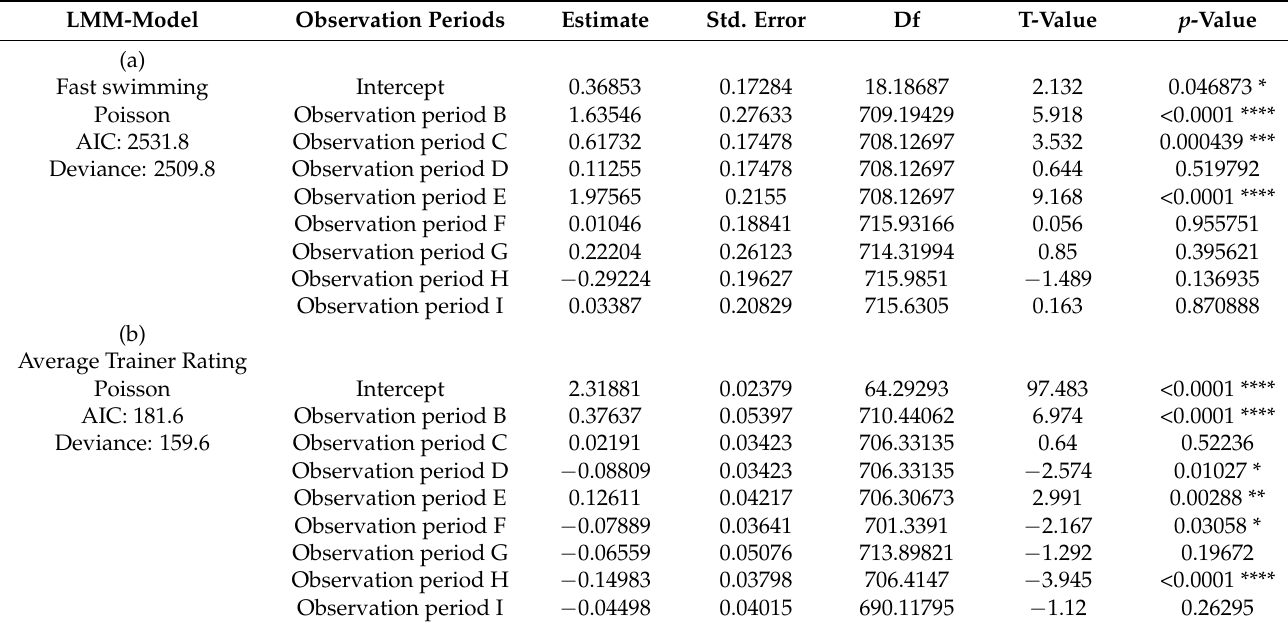
Table 5. Statistical results of the Poisson distributed linear mixed-effect models (LMMs). The results show the effect of each observation period on the frequency of fast swimming, as well as the average overall trainer rating of each dolphin.